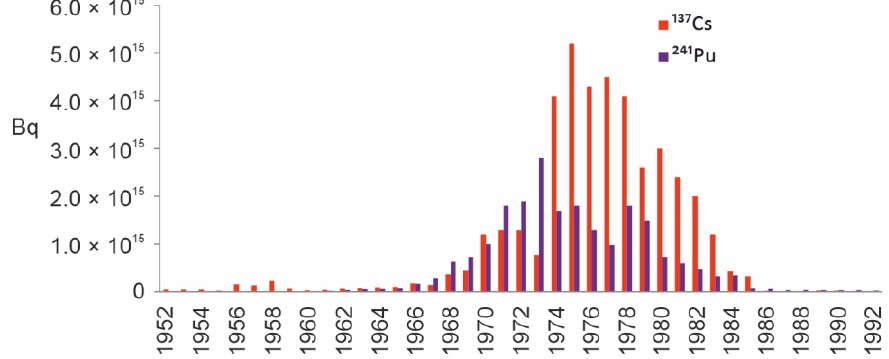
Figure 18. 137 Cs and 241 Pu discharges into the Irish Sea [88].